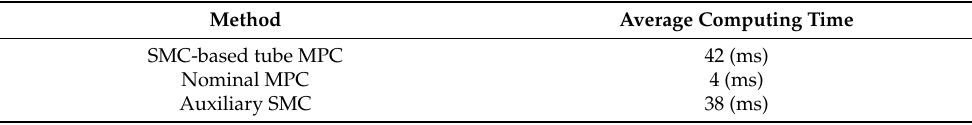
Table 7. Average computing time.